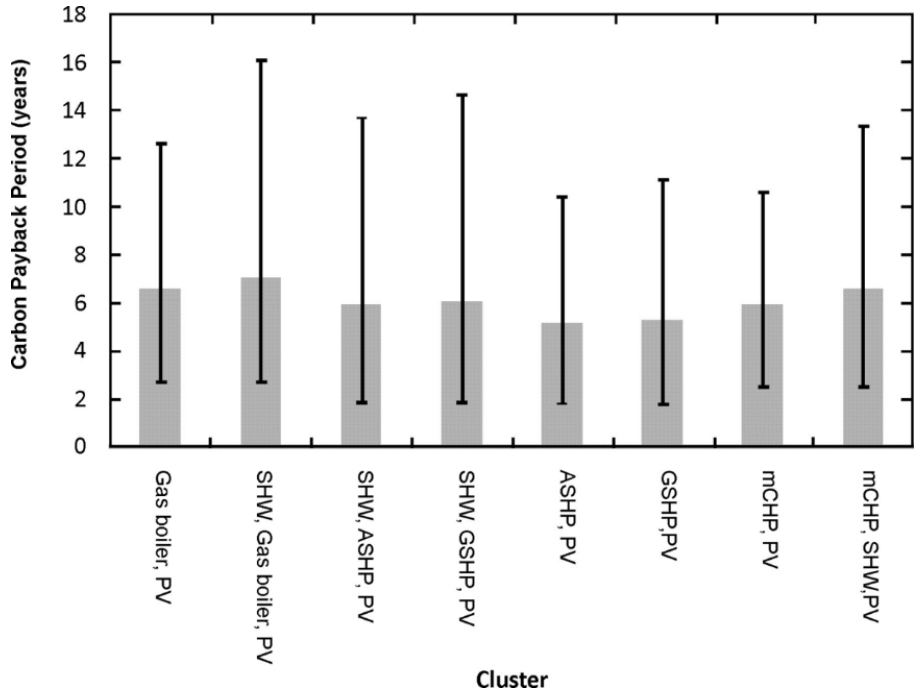
Figure 15. Carbon payback periods for a range of clustered micro-generators. Source: Reprinted with permission from Ref. [21]. 2020, KeAi Communications.